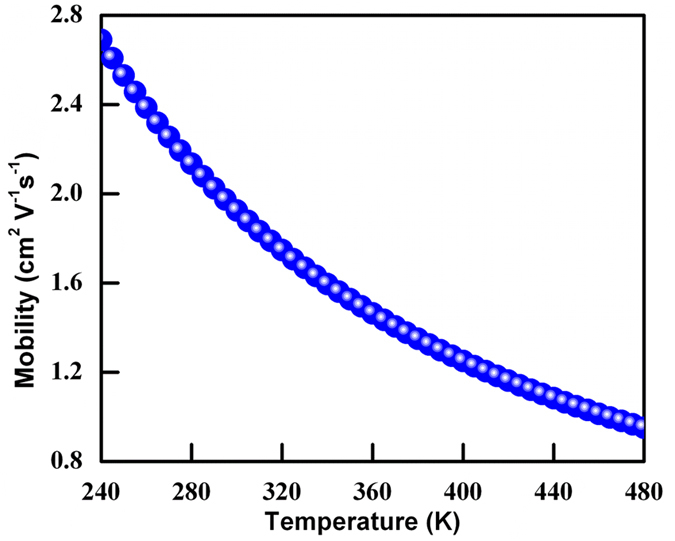
Mobility as a function of Temperature of 3D flower type MoS2.